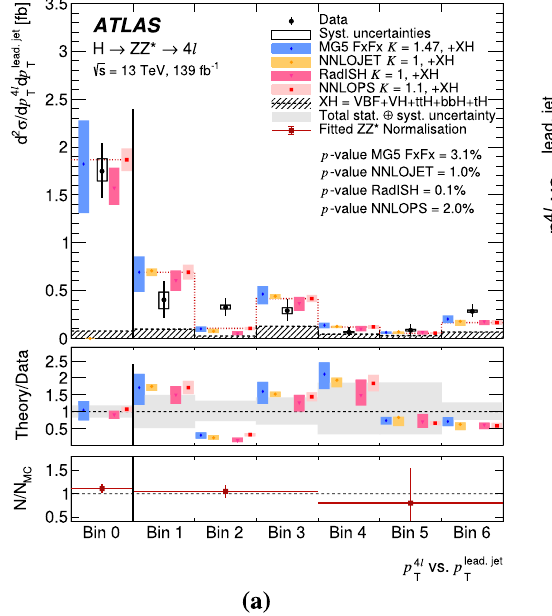
matrix between the measured cross sections and the Z Z ∗ background normalisation factors. The bin boundaries are defined in Fig. 15